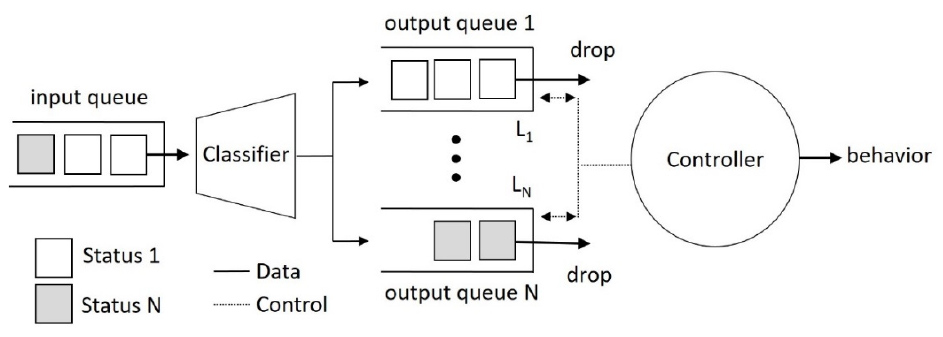
Figure 4. Status classification queueing system.